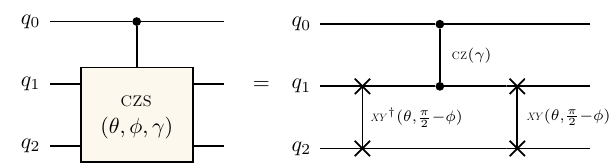
(θ , φ , γ ) then always CZS